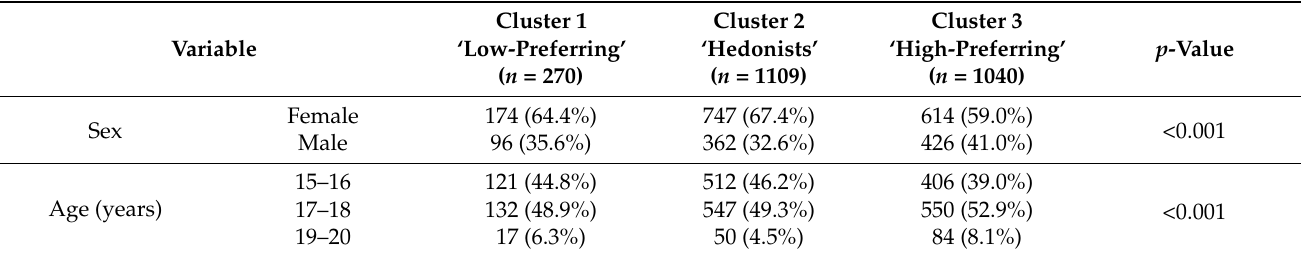
Table 2. The demographic characteristics within the clusters stratified based on the preferences assessed while using the Food Preference Questionnaire (FPQ) within the population of the second phase of the Polish Adolescents’ COVID-19 Experience (PLACE-19) Study ( n = 2419).